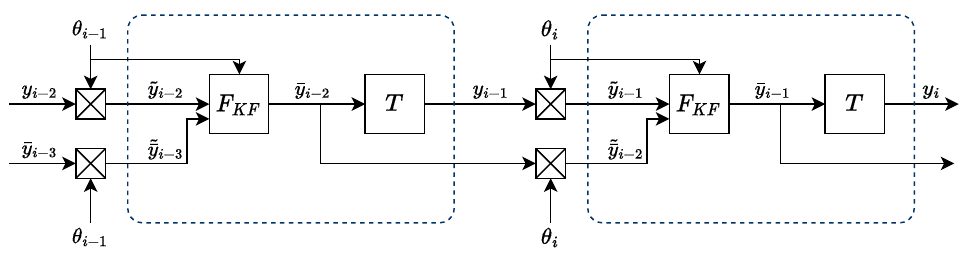
Figure 10. Overview of the proposed compensation strategy based on the intermittent Kalman filter ( F KF )